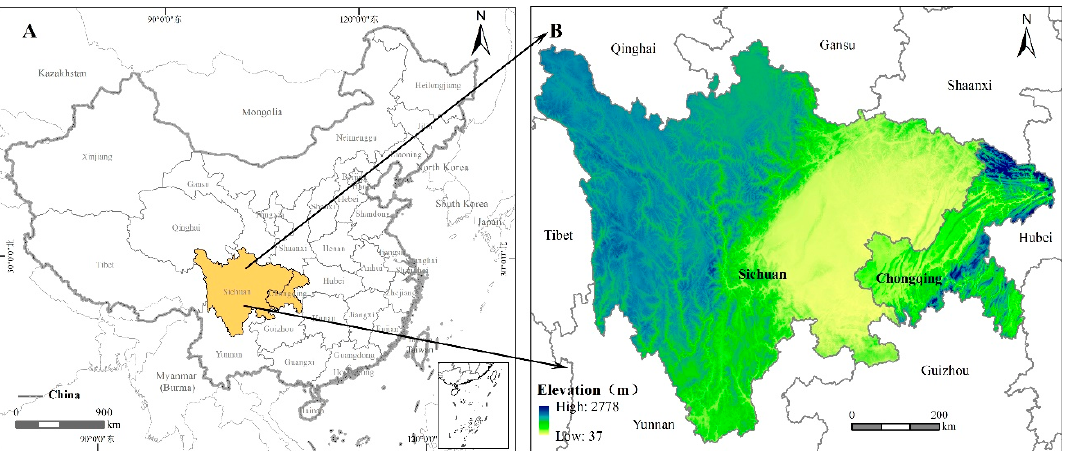
Figure 2. The location of study area. ( A ) depicts the location of Sichuan and Chongqing Provinces, and ( B) presents the elevation information, which indicates that nearly half of the Sichuan Province is occupied by plain areas and the Chongqing is a typical hilly and mountainous region).